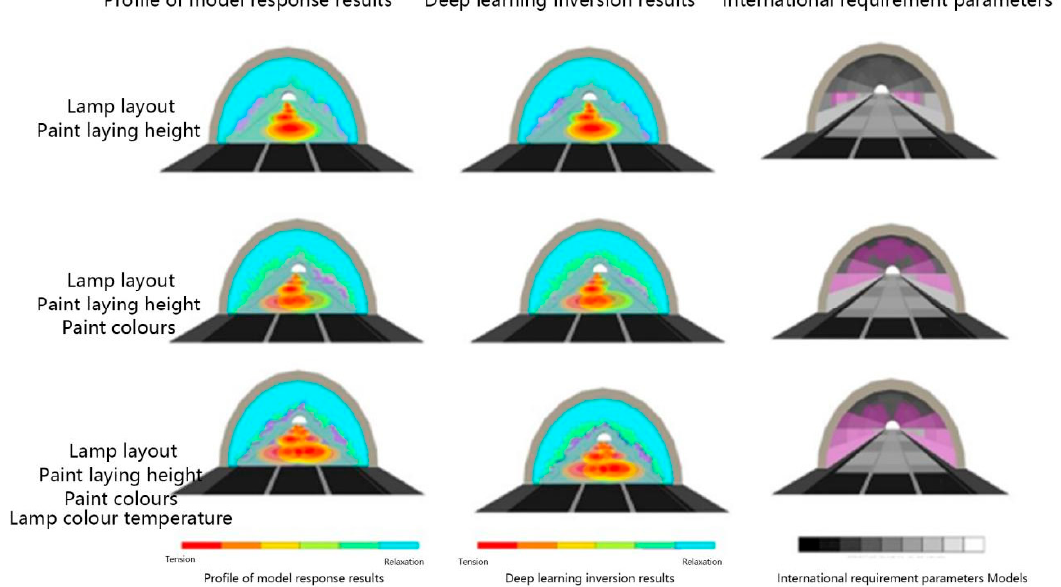
Figure 11. A comprehensive comparative computing analysis of four factors of tunnel light envi- ronment.